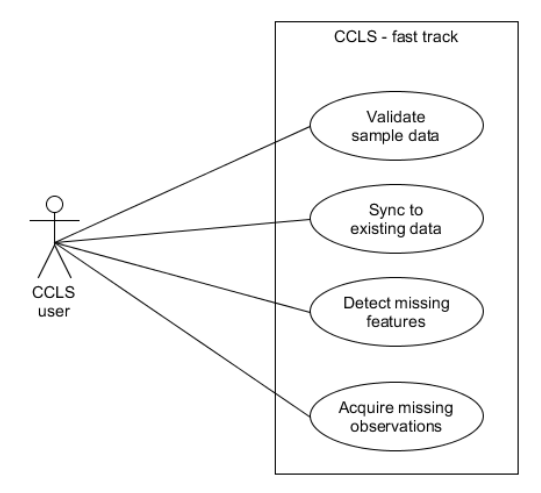
Figure 11: CCLS fast track use case UML